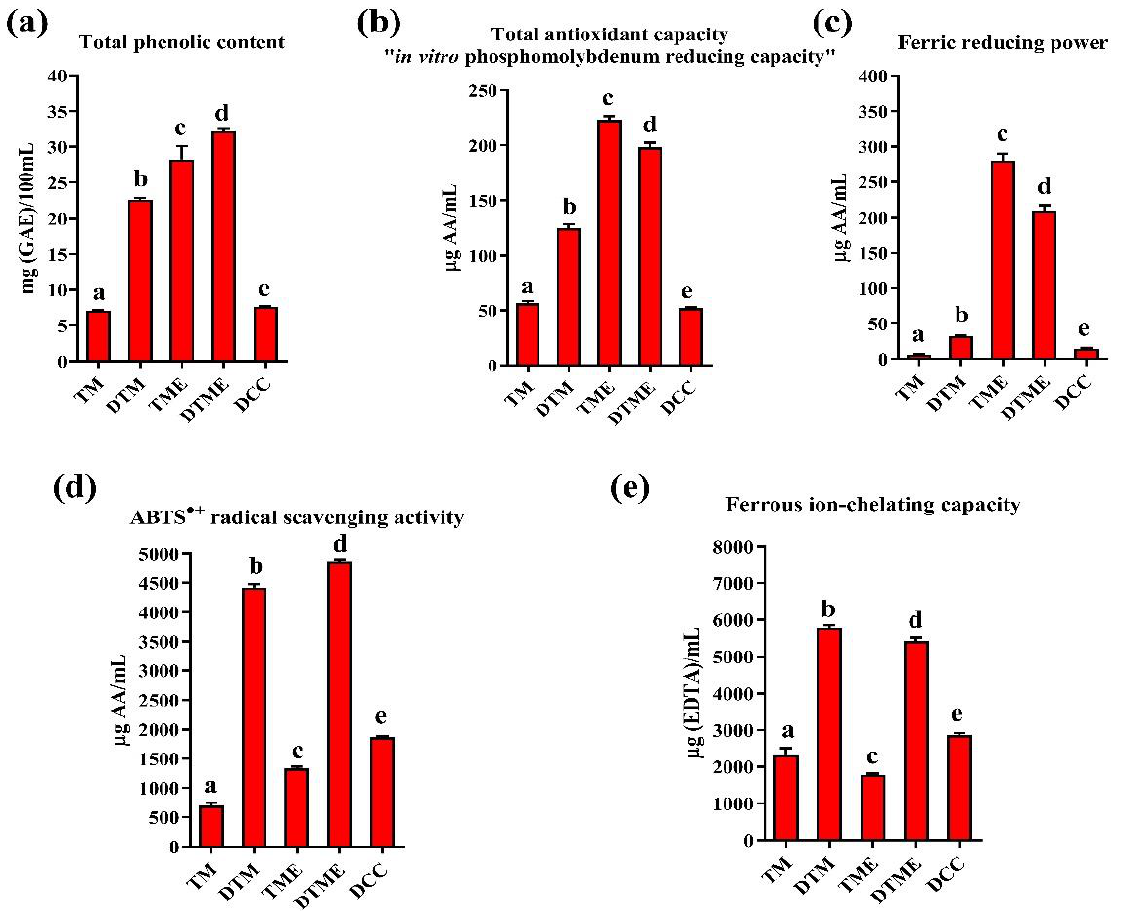
Figure 2. Total phenolic content ( a ) and antioxidant properties ( b – e ) of TM and TME samples before and after in vitro gastrointestinal digestion. Bars followed by the same lower letters are not significantly different according to t -test ( p < 0.05), n = 3. n.d — not detected. Samples: TM — undigested